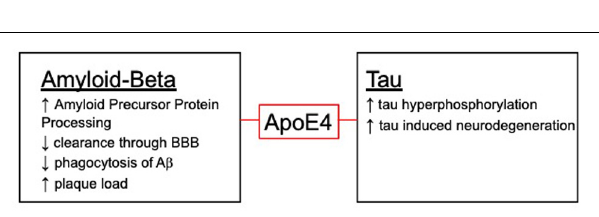
FIGURE 2 | The role ApoE4 plays with the hallmark AD